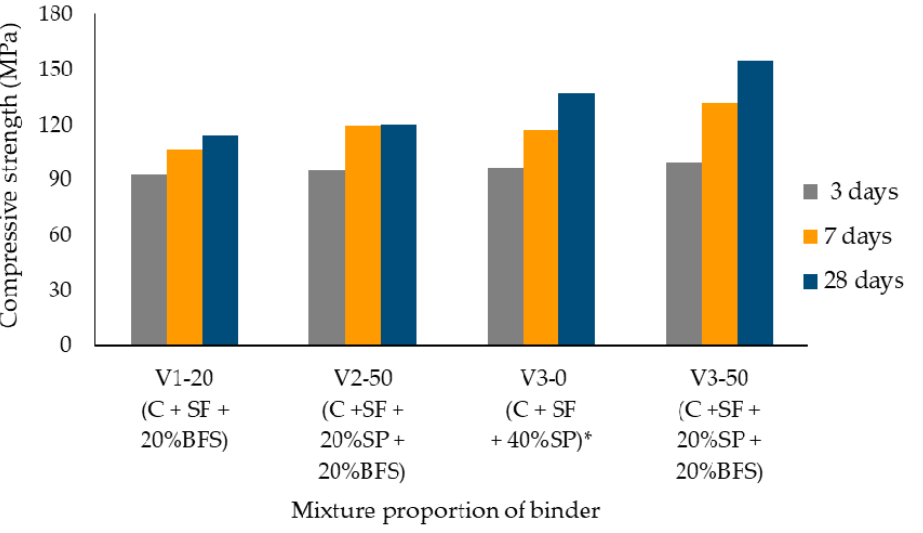
Figure 15. Comparing the compressive strength of groups. * C: cement, SF: silica fume, SP: silica powder. It can be seen that adding mineral admixture (silica fume and slag) enhances the microstructure and the compressive strength of concrete [39]. The reaction between slag and Ca(OH) 2 increases C-S-H content which improves the strength of the hardened cement paste. The microstructure of the C3-50 sample at 28 days of age was investigated by the scanning electron microscope (SEM) method. Figure 16a shows the sheet-shaped C-S-H and needles crystals of ettringite. Moreover, the C-S-H crystal is recorded as a multilayered structure in Figure 16b. The multilayered crystal reflects the tightly packed and cohesive form [40,41], thereby increasing the compaction of the cement